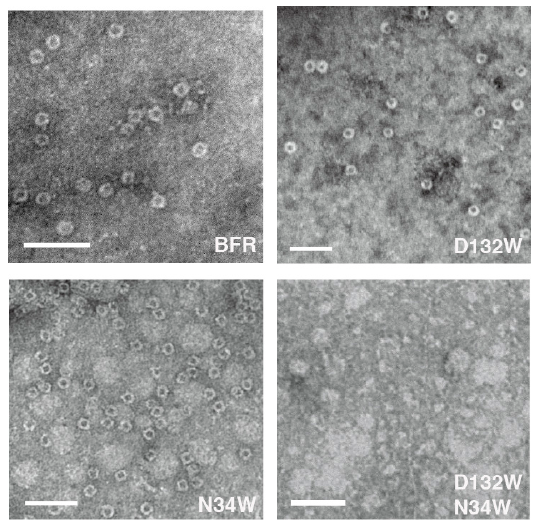
Figure 4. Two of the three BFR-derived mutants can form nano-cages under TEM conditions, the exception being D132W/N34W. Scale bars indicate 50 nm. Table 1. Average particle diameters of three BFR-derived mutants at B-site